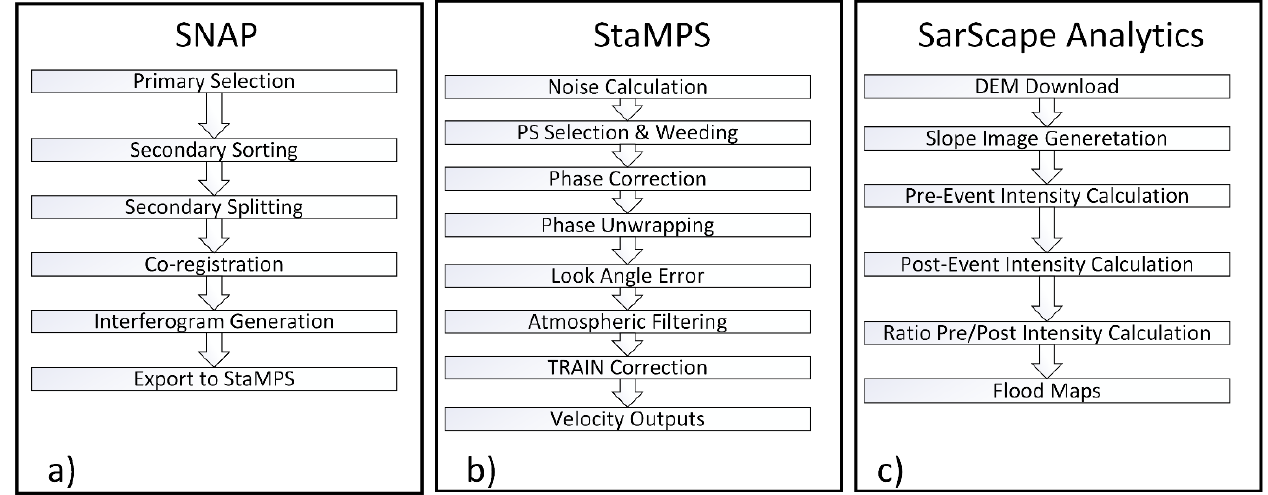
Figure 5. ( a ) SNAP and ( b ) StaMPS workflows used to generate land deformation rates. ( c ) SARScape Analytics workflow used for flood mapping.